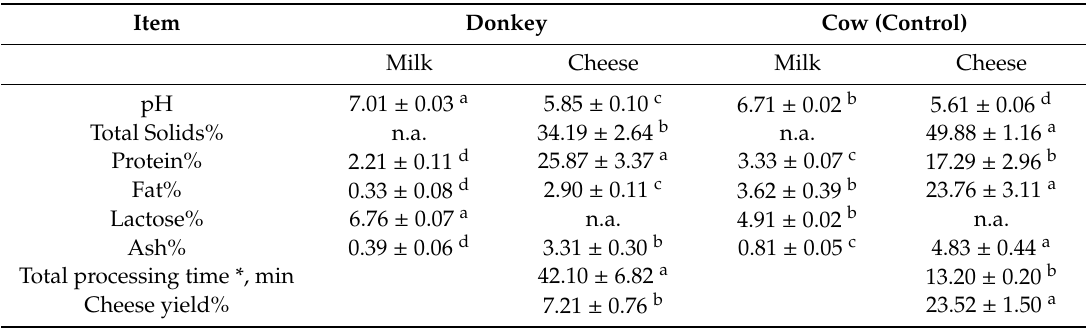
Table 1. Chemical characteristics of donkey and cow milk and corresponding cheeses (mean values ± standard deviation (SD)).